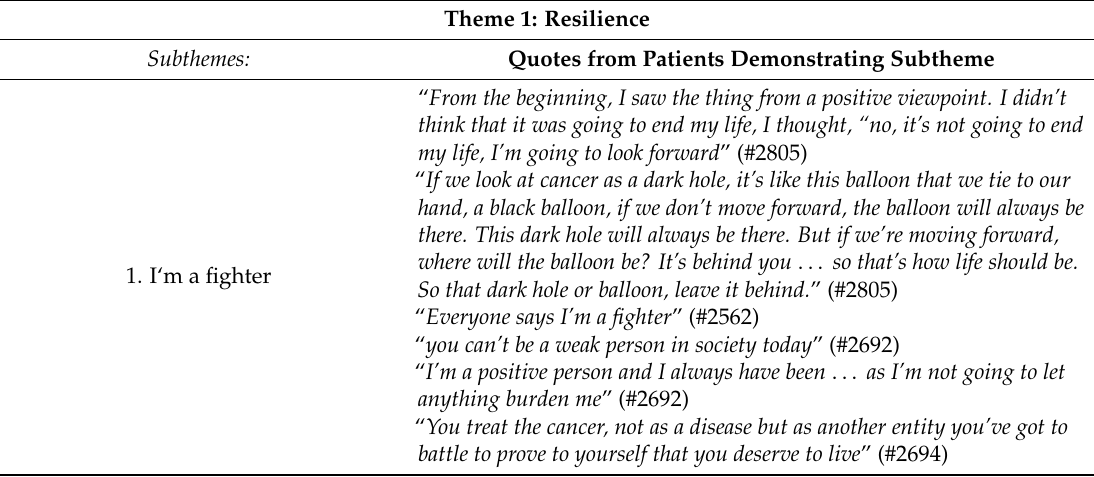
Table 3. Supporting quotes for major